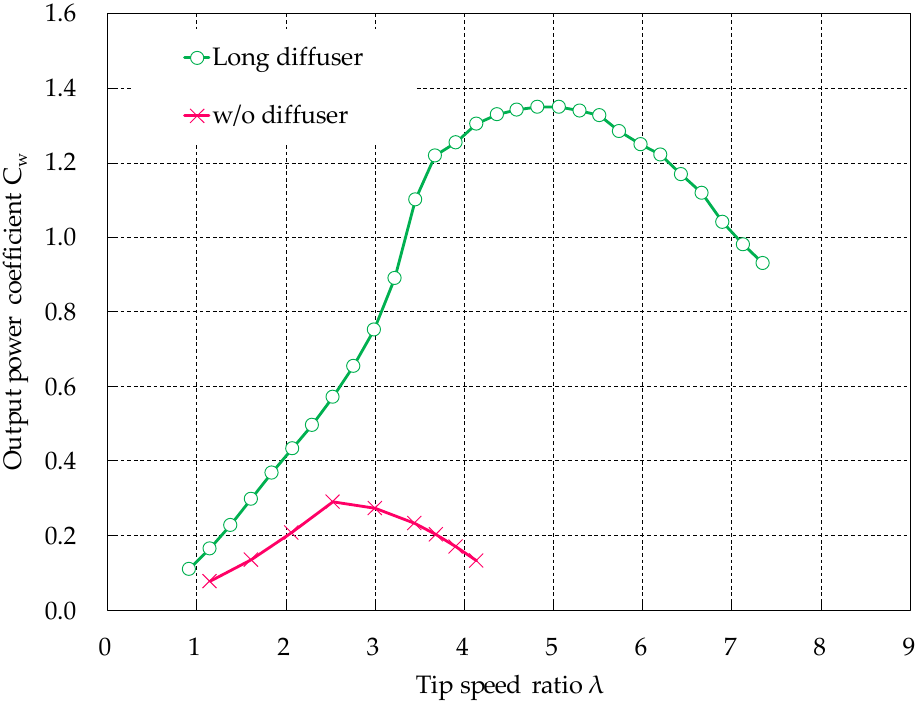
Figure 10. Power curves vs. λ (tip speed ratio) for a wind turbine with long diffuser and large brim and bare turbine. C w is the output power coefficient.